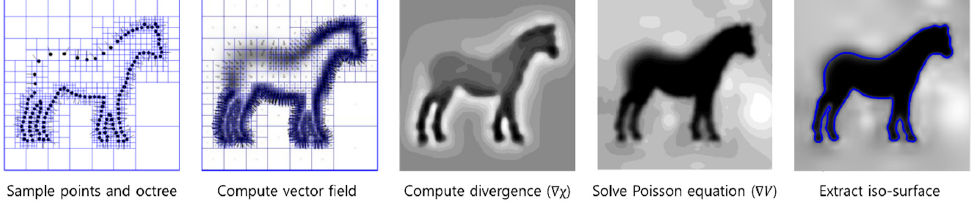
Figure 5. Example of Poisson surface reconstruction in 2D.